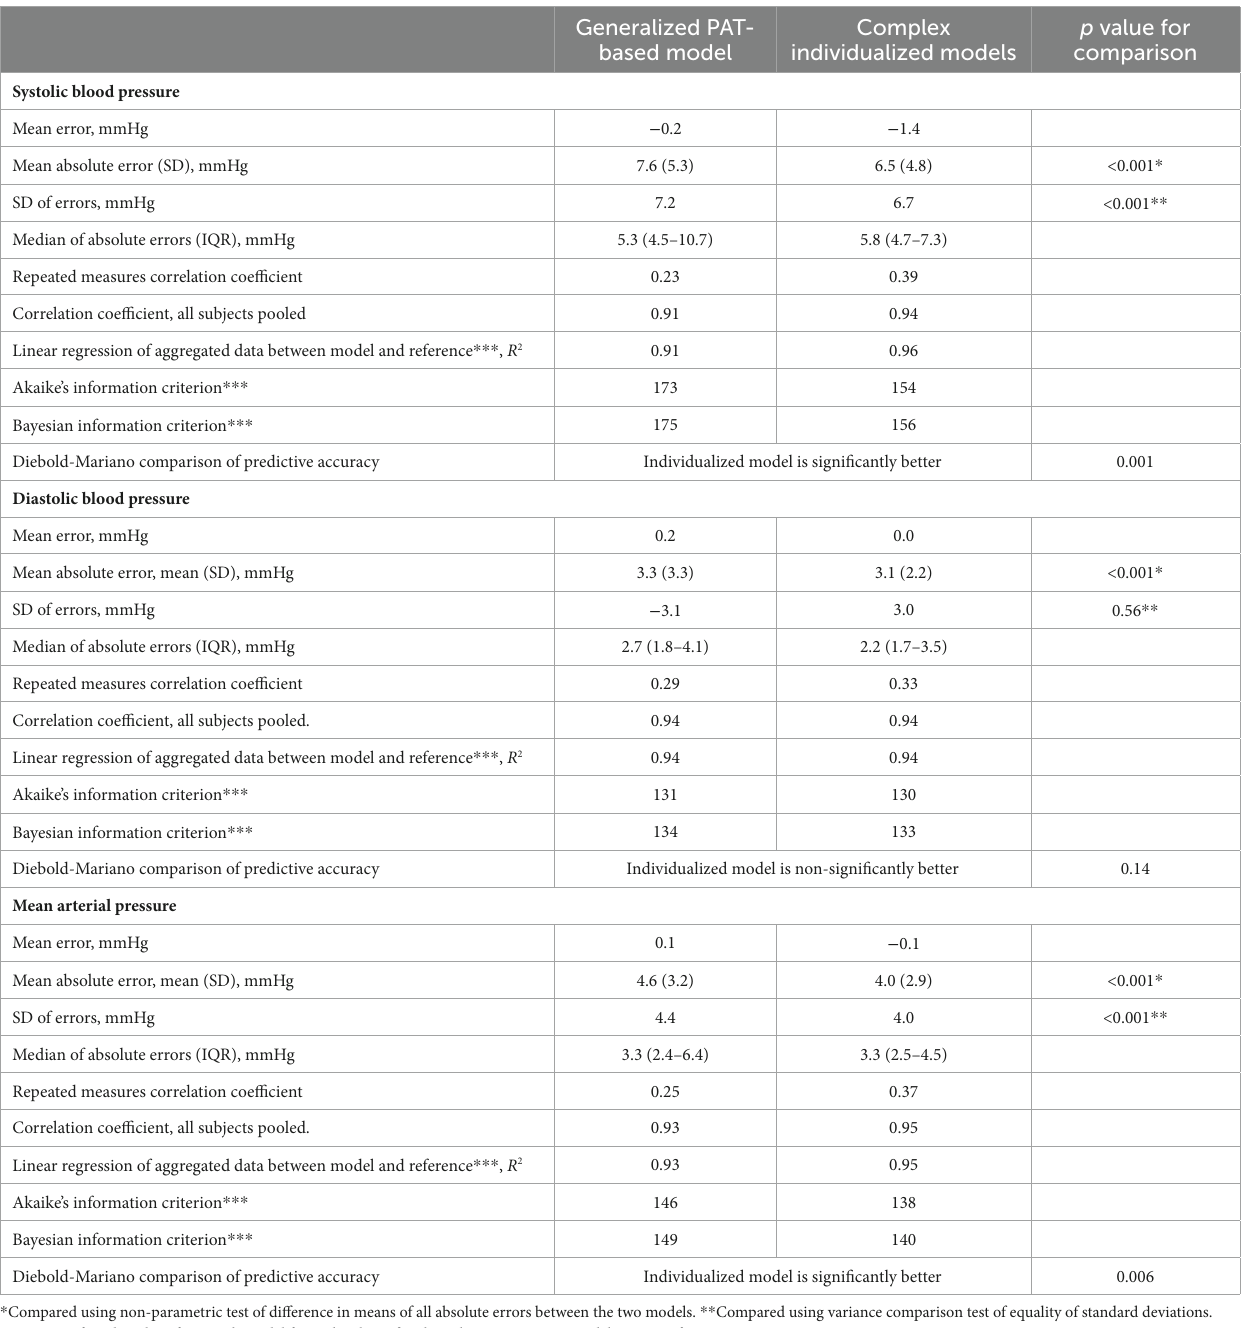
TABLE 3 Performance of the generalized PAT-based model, the complex individualized models and comparison of the two.